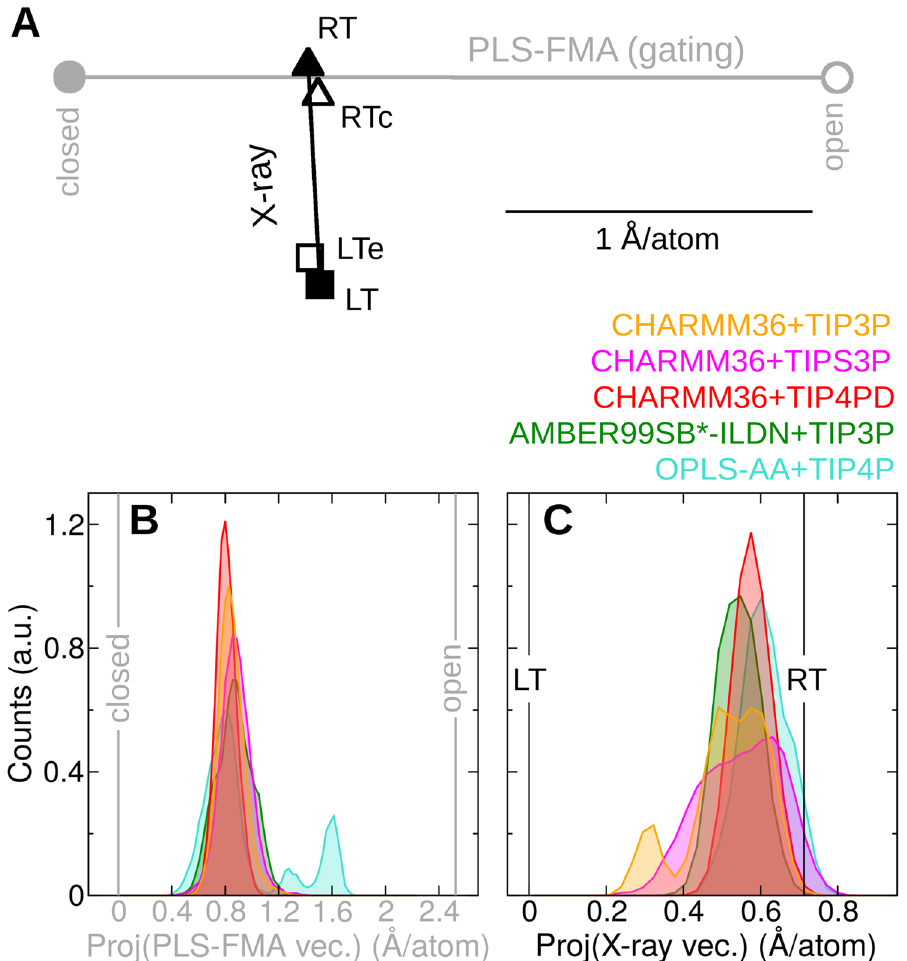
Figure 4. Conformational ensemble of Aqy1 at room temperature recovered from MD simulations. ( A ) Two- dimensional (2D) space constituted by vector associated to gating obtained by PLS-FMA (gray) and the vector connecting the X-ray structures (black). The PLS-FMA vector connects the extreme closed (filled circle) and open (empty circle) conformations. The X-ray vector connects the RT (filled triangle) with the LT (filled square) structures. These two vectors were found almost orthogonal (forming an angle of 86°). Projections of scaled conformations by a factor equal to the change in the crystallographic cell size during freezing are also displayed. Conformation at room temperature was compressed (RTc, empty triangle) while at low temperature was expanded (LTe, empty square). The horizontal black line represent a collective motion with each atom moving in average 1 Å. ( B , C ) Histograms of the projections of MD trajectories at room temperature along the PLS-FMA vector ( B ) and the X-ray vector ( C ) is presented for the five-used